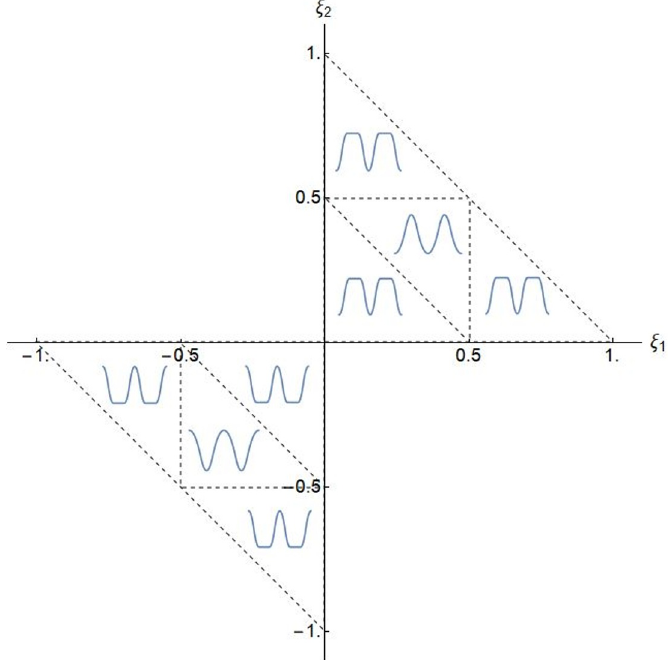
Figure 2 . The qualitative — or catastrophic — profile of the pairwise potential for the holonomies, V h ( x ) , drawn over the range x ∈ ( − 1 , 1) of the pair’s separation, for fixed ξ 1 , 2 and fixed k 1 , 2 > 0 , in the two complementary wings of the space of the control-parameters ξ . (Note that ξ are 1 , 2 1 , 2 1-periodic: ξ +1 , so the two wings cover a fundamental domain.) The dashed lines indicate 1 , 2 ∼ ξ 1 , 2 the bifurcation sets across which the qualitative behavior changes. In particular, on the upper-right wing the potential is M-shaped and the holonomies attract each other, while on the lower-left wing it is W-shaped and the holonomies repel [18]. (Note that the holonomies are also 1-periodic.) The qualitative change on a single wing is more fine-grained — less catastrophic — and was not emphasized in [18]: it only involves appearance or disappearance of plateaux in the potential. The plateaux on the W wing will be associated to the breakdown of the non-renormalization of log I in section 4. The M and W wings switch places if k are taken to be negative 1 , 2